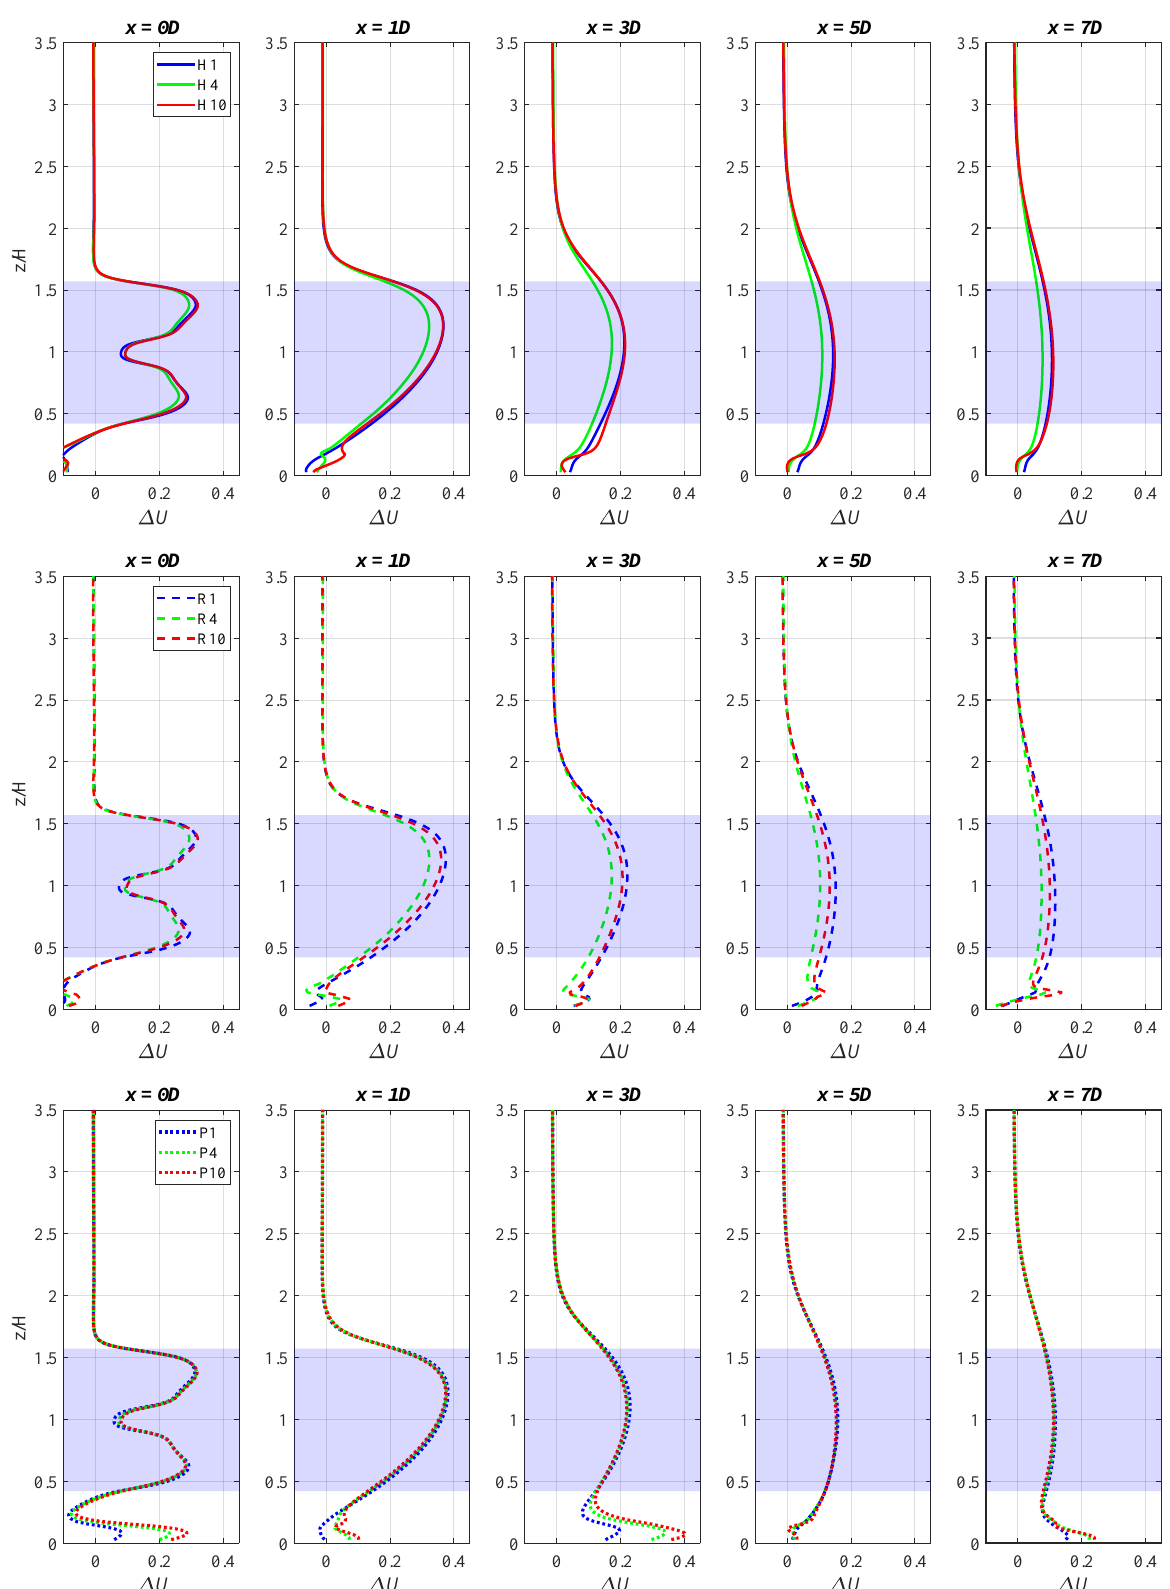
Figure 18. Vertical profiles of velocity deficits ( ∆ U) from the midplane in different heterogeneous cases with varying densities; ( up ) homogeneous cases, ( middle ) real cases, ( down ) patched cases. The purple shaded region is the turbine rotor